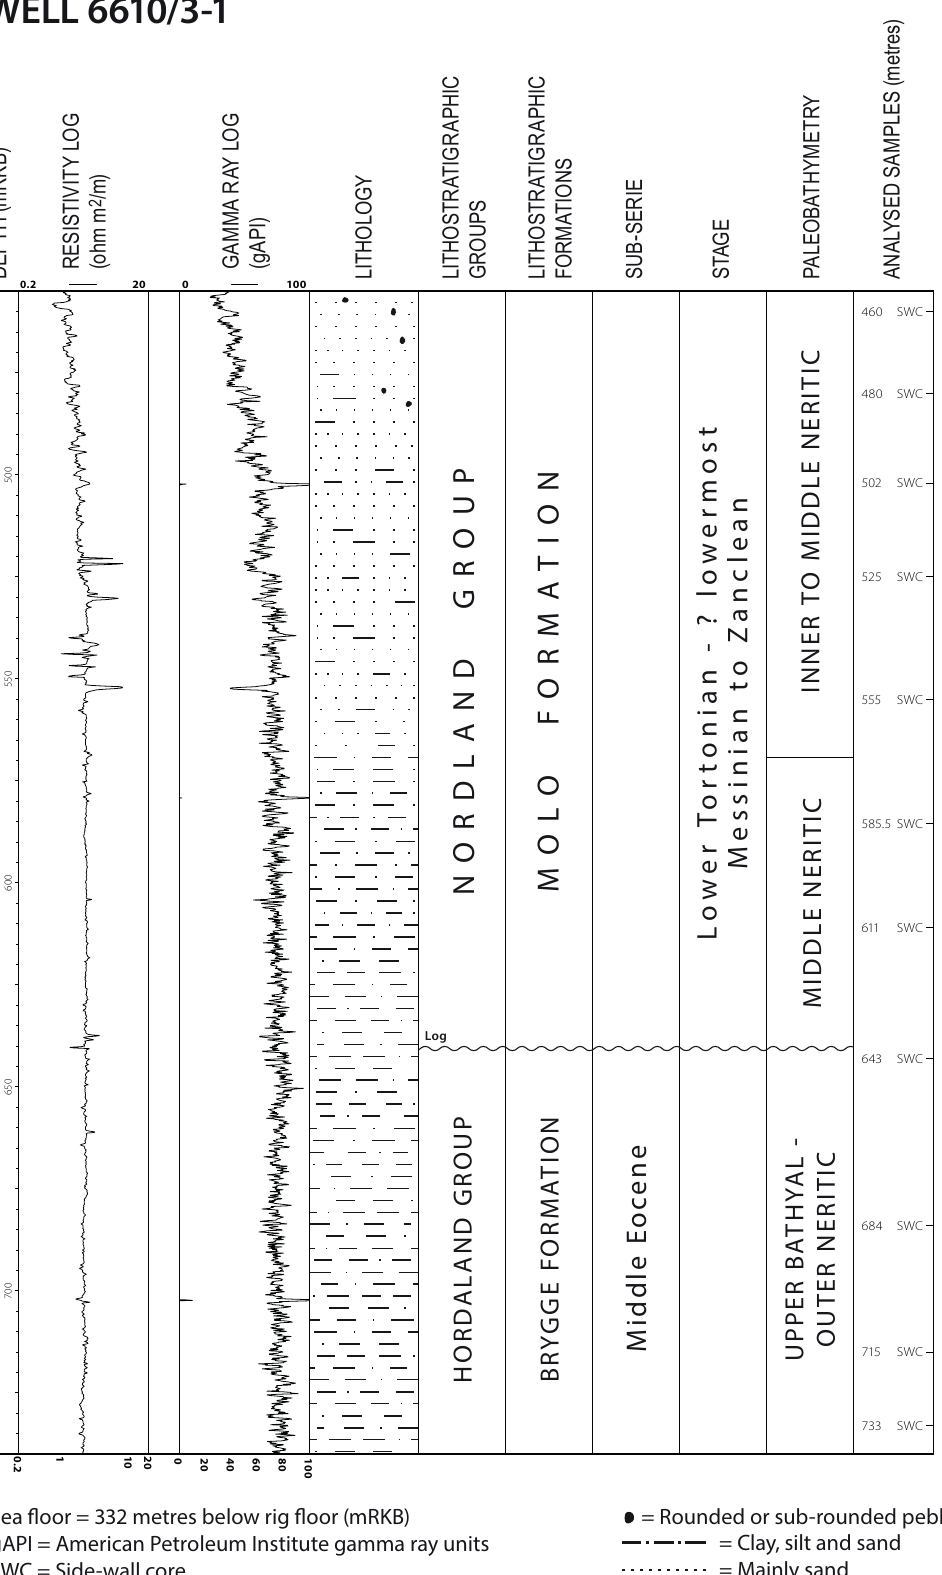
= Rounded or sub-rounded pebbles = Clay, silt and sand = Mainly sand